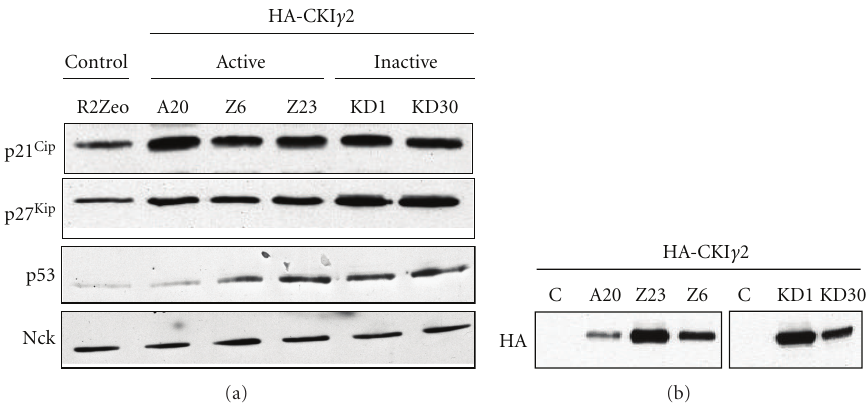
Figure 9: E ff ect of CKI γ 2 overexpression on the CDK inhibitors p21 Cip1 and p27 Kip1 and the tumor suppressor p53 expression levels. (a) From indicated cell lines, equivalent amount of total cell lysate proteins was subjected to Western Blot analysis using specific antibodies against p21 Cip1 , p27 Kip1 , and p53. Nck Western Blot was used as loading control. (b) Similar samples were probed by western blot with anti-HA antibodies.